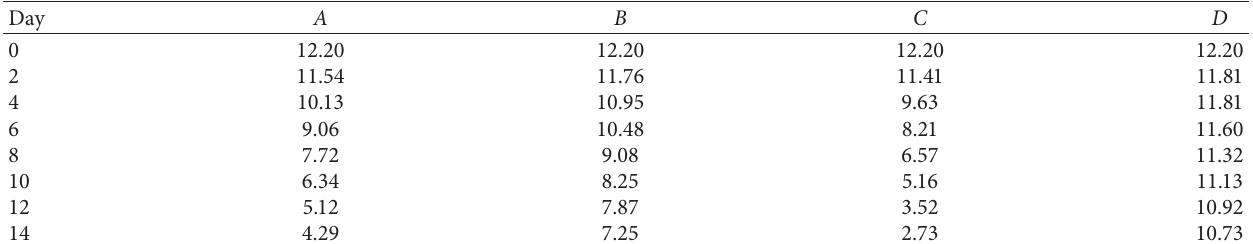
Table 5: Microbial-plant combined treatment wastewater total nitrogen content change data table.